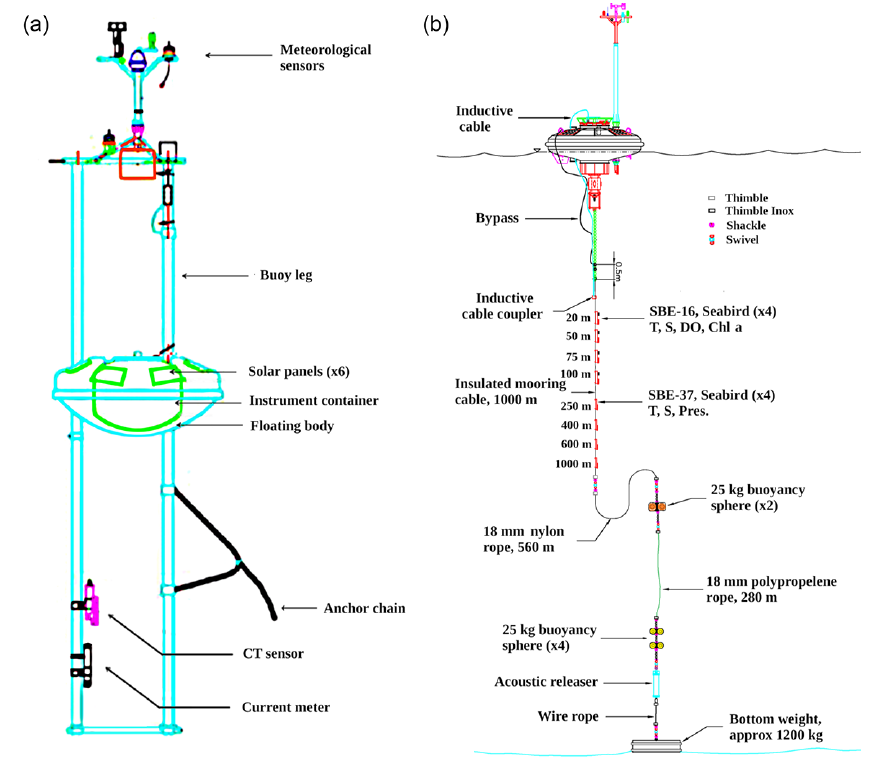
Figure 3. Coastal (a) and open sea (b) fixed platform configuration with a scheme of the